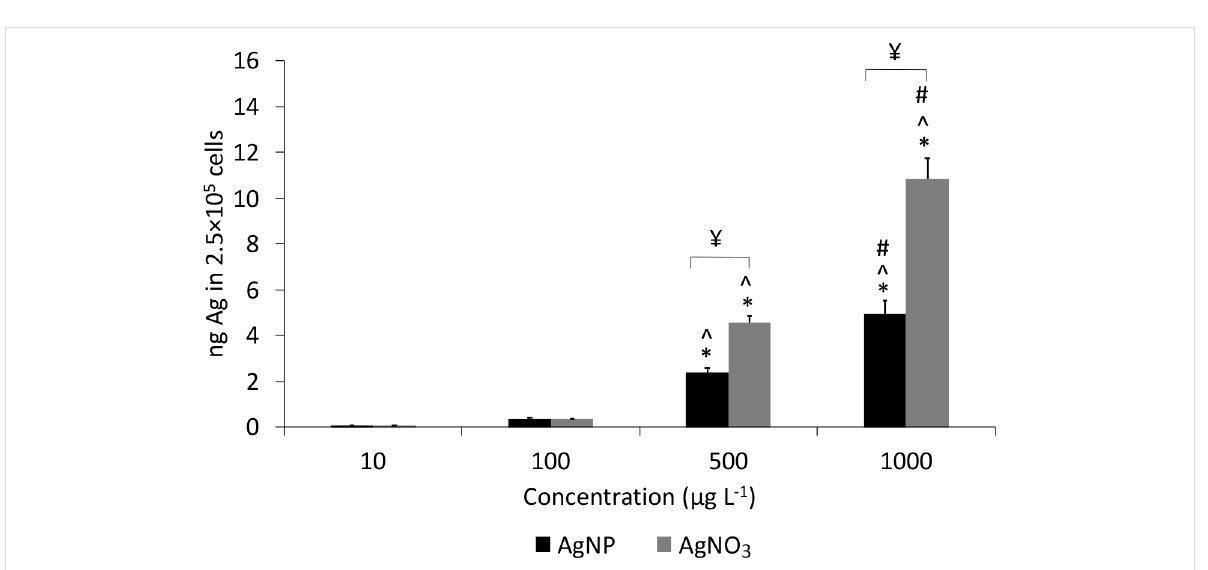
Figure 4: Ag uptake (ng) in 2.5 × 10 5 cells. ICP-MS measurements of Ag that was adsorbed or attached to the cell surface after treatments with PVP- AgNPs and AgNO 3 after 24 h of exposure. Data are presented as mean ± SE ( n = 6). * statistically different from 10 µg·L − 1 , ^ statistically different from 100 µg·L − 1 , # statistically different from 500 µg·L − 1 , and ¥ statistically different when compared with the AgNP